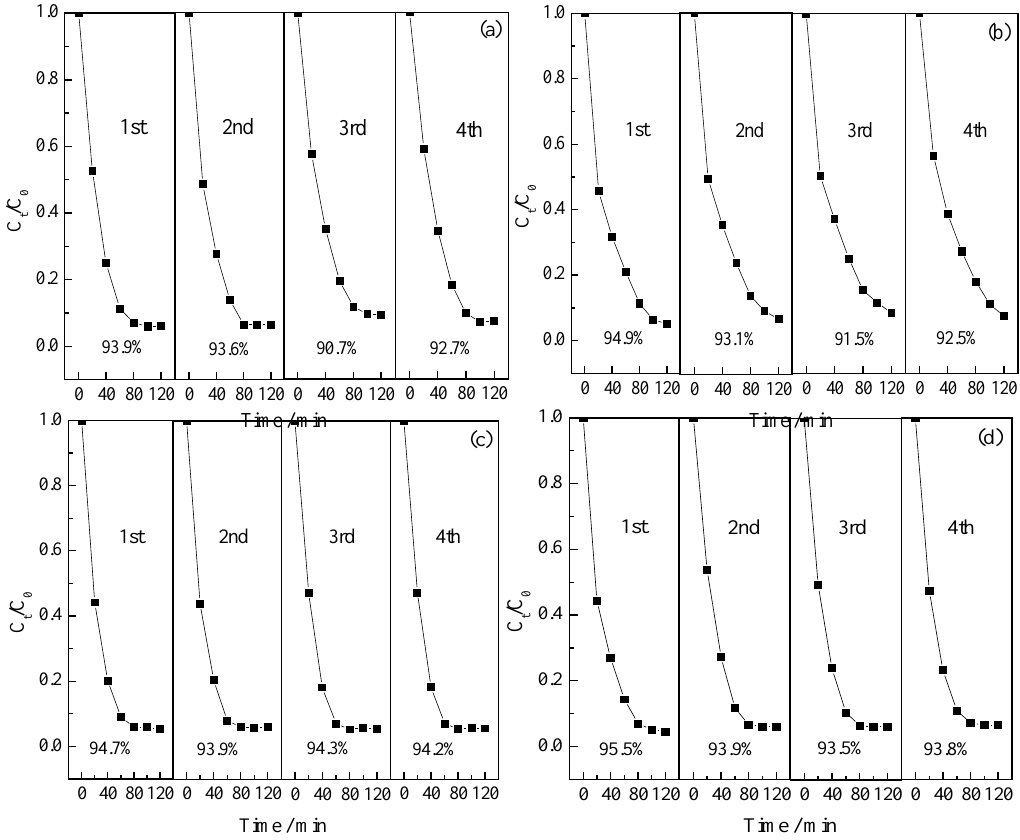
Figure 9. Recycling test of RE/TiO 2 for photocatalytic degradation of BHA. ( a ) 0.75%La/TiO 2 ; ( b ) 0.20%Ce/TiO 2 ; ( c ) 0.70%Gd/TiO 2 ; ( d ) 0.50%Yb/TiO 2 .